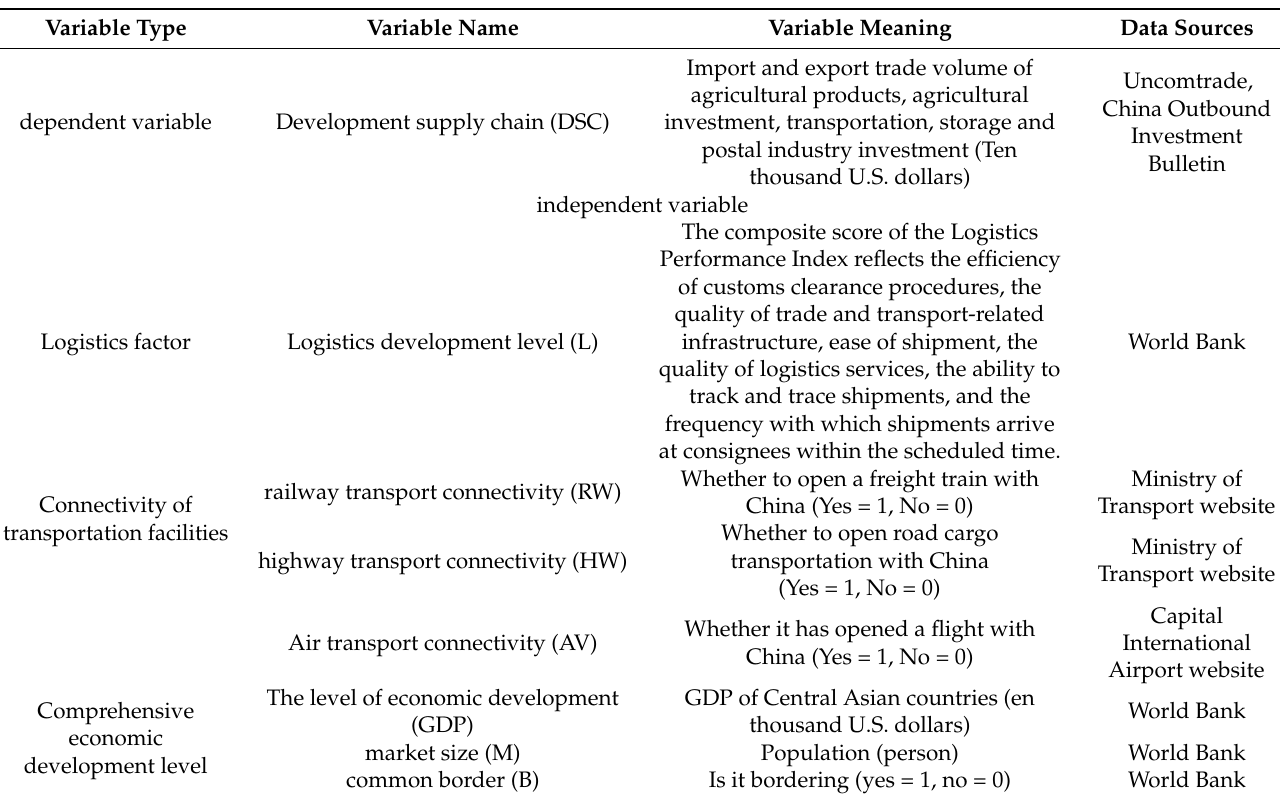
Table 1. Meaning of each variable.